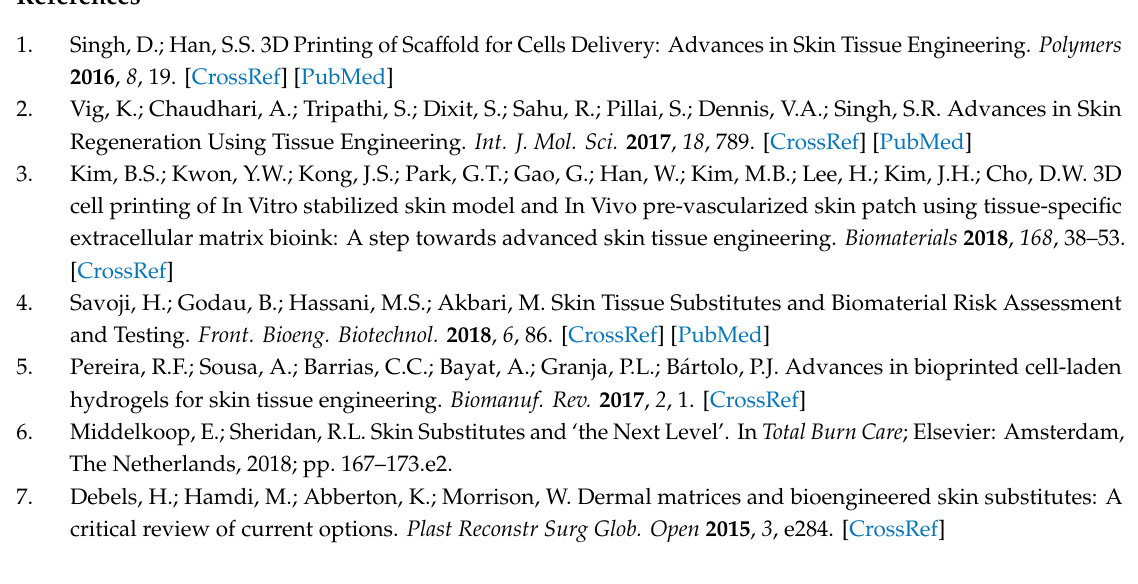
Figure S7: SEM micrograph of a keratinocyte cell attached to the sca ff old surface. Details about the used SEM method is described in Supplementary